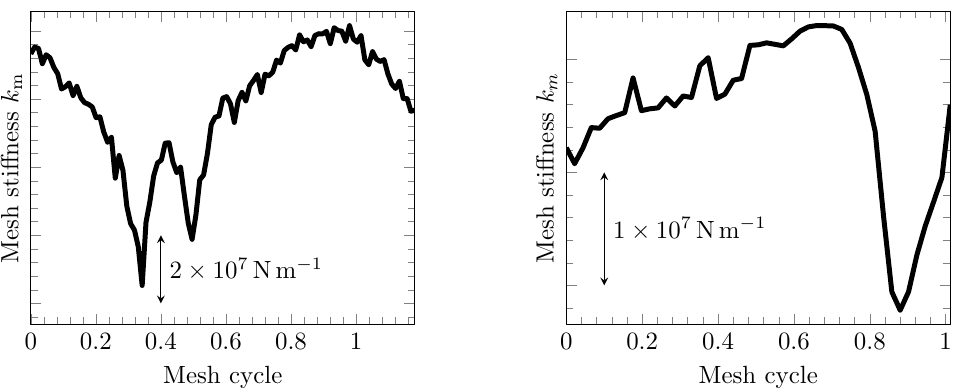
Figure 15. Results for the varying mesh stiffness of the IS ( left ) and HS gear stage ( right ), obtained from series of static simulations using detailed FE-models of the specific gear stages.